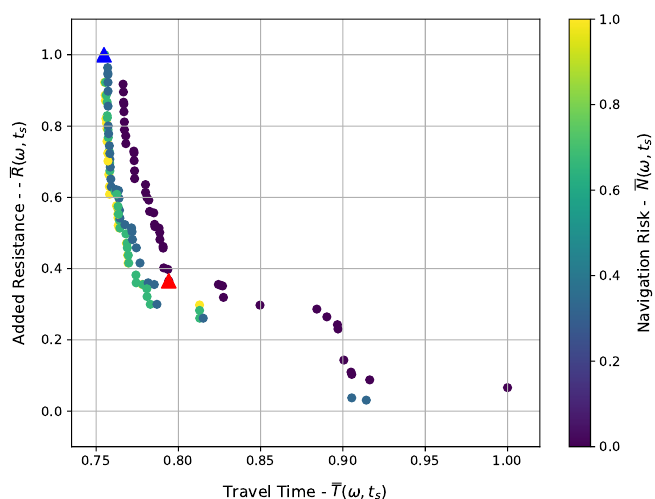
Figure 9. Set of Pareto efficient solutions at the output of the planning layer for the selected scenario. The solutions are plotted in the 3-dimension space: x axis—travel time, y axis—navigation added resistance and the color domain to identify the routes by risk. The red triangular marker identifies the route representing the best trade-off solution respect to the Utopia point. The blue triangular marker identifies the costs associated with the nominal route